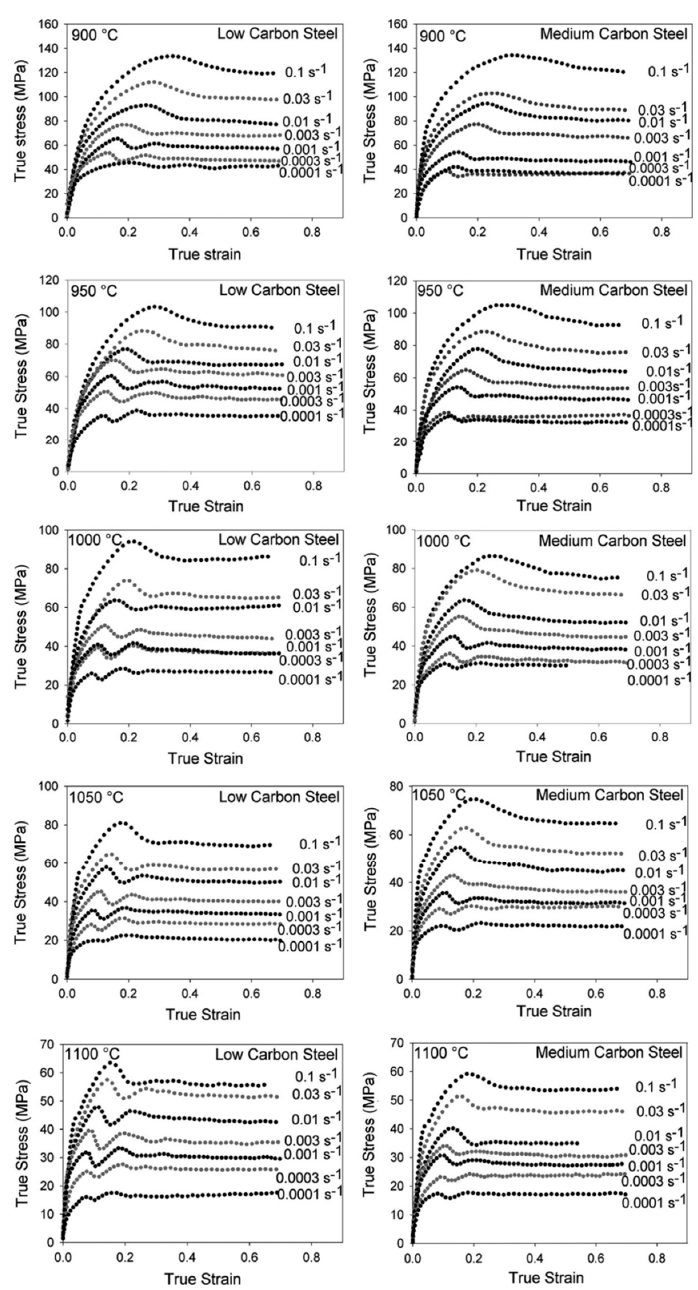
Figure 17. Flow curves at different deformation conditions [103] .